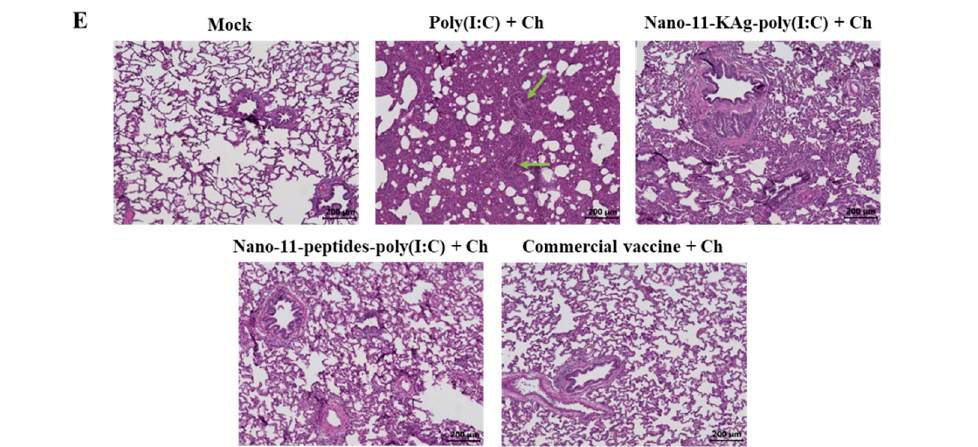
Figure 7. Nano-11 and commercial influenza vaccines reduced the challenge virus titer and virus induced lung pathology. Pigs were vaccinated twice with poly(I:C) adjuvanted Nano-11-based vaccines (containing H1N2-OH10 virus or 10 peptides) or commercial vaccine (containing H1N1, H1N2 and H3N2 viruses) and challenged (H1N1-OH7 virus) at 35 days post prime vaccination. Samples collected at day six post-challenge were used in the analyses. Challenge live SwIAV titer in ( A ) Nasal swab; ( B ) BAL fluid; and ( C ) Lung lysate. ( D ) Severity of lung lesions based on evaluation of hematoxylin and eosin-stained sections; and ( E ) Representative lung sections of experimental pigs in each group stained with hematoxylin and eosin were examined and microscopic images were taken at 10 × magnification (green arrows show the sites of inflammation). Data represent the mean value of four to five pigs ± SEM.